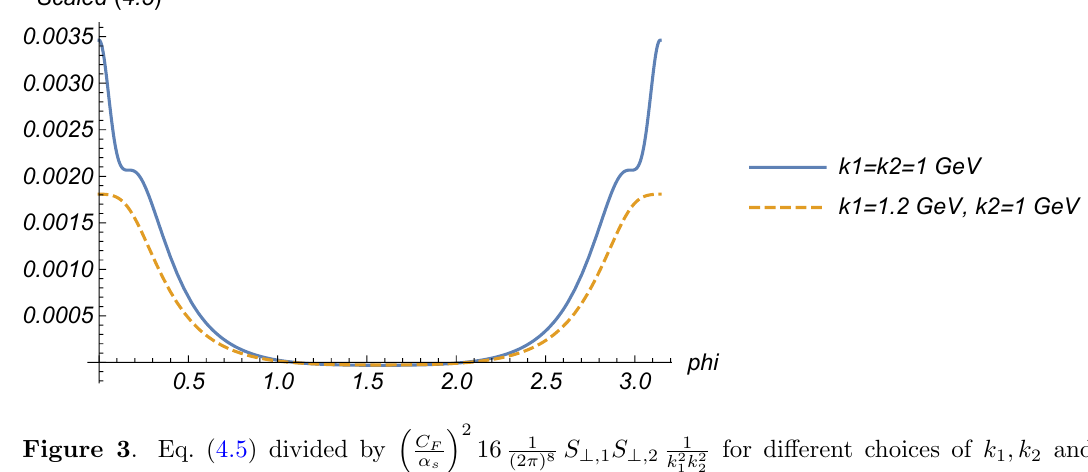
Figure 3 . Eq. (4.5) divided by Q 1 = 0 : 2 GeV and Q 2 = 1 GeV, versus the angle (cid:30) between them. Using the projectile distribution, eq. (4.1), and the target distribution, eq. (4.3), the